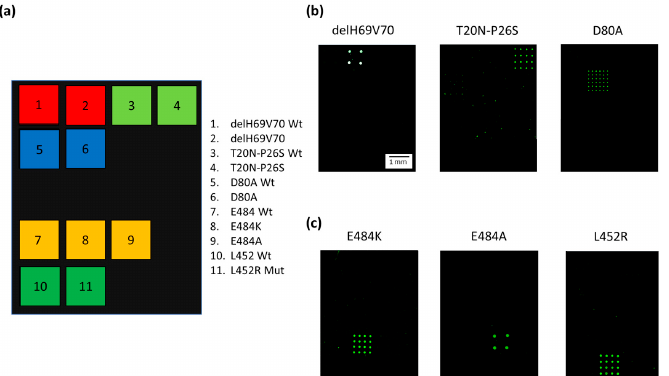
Figure 3. ( a ) Spotting schematic of the array. Silicon chips coated with MCP-4 are used as substrates for the covalent binding of amino-modified capture probe oligonucleotides arrayed at discrete locations. Each position in the grid identifies an individual capture probe address corresponding to the mutations described in the legend. ( b ) Cy3 fluorescence images of three different silicon chips. Each array is hybridized with an individual Cy3 labeled PCR (Amplicon1, positions 23 to 289nt in the S protein coding sequence) incubated with Dual-domain reporters corresponding to delH69V70 and T20N-P26S and D80A mutations respectively. ( c ) Cy3 fluorescence images of three different silicon chips. Each array is hybridized with an individual Cy3 labeled PCR (Amplicon2, positions 1215 to 1545 nt in the S protein coding sequence) incubated with dual probe reporters corresponding to E484K, E848A, and L452R mutations. The spots are 150 μ m large with a pitch of 350 μ m. The scale bar (1 mm) is the same in ( b ) and ( c ).